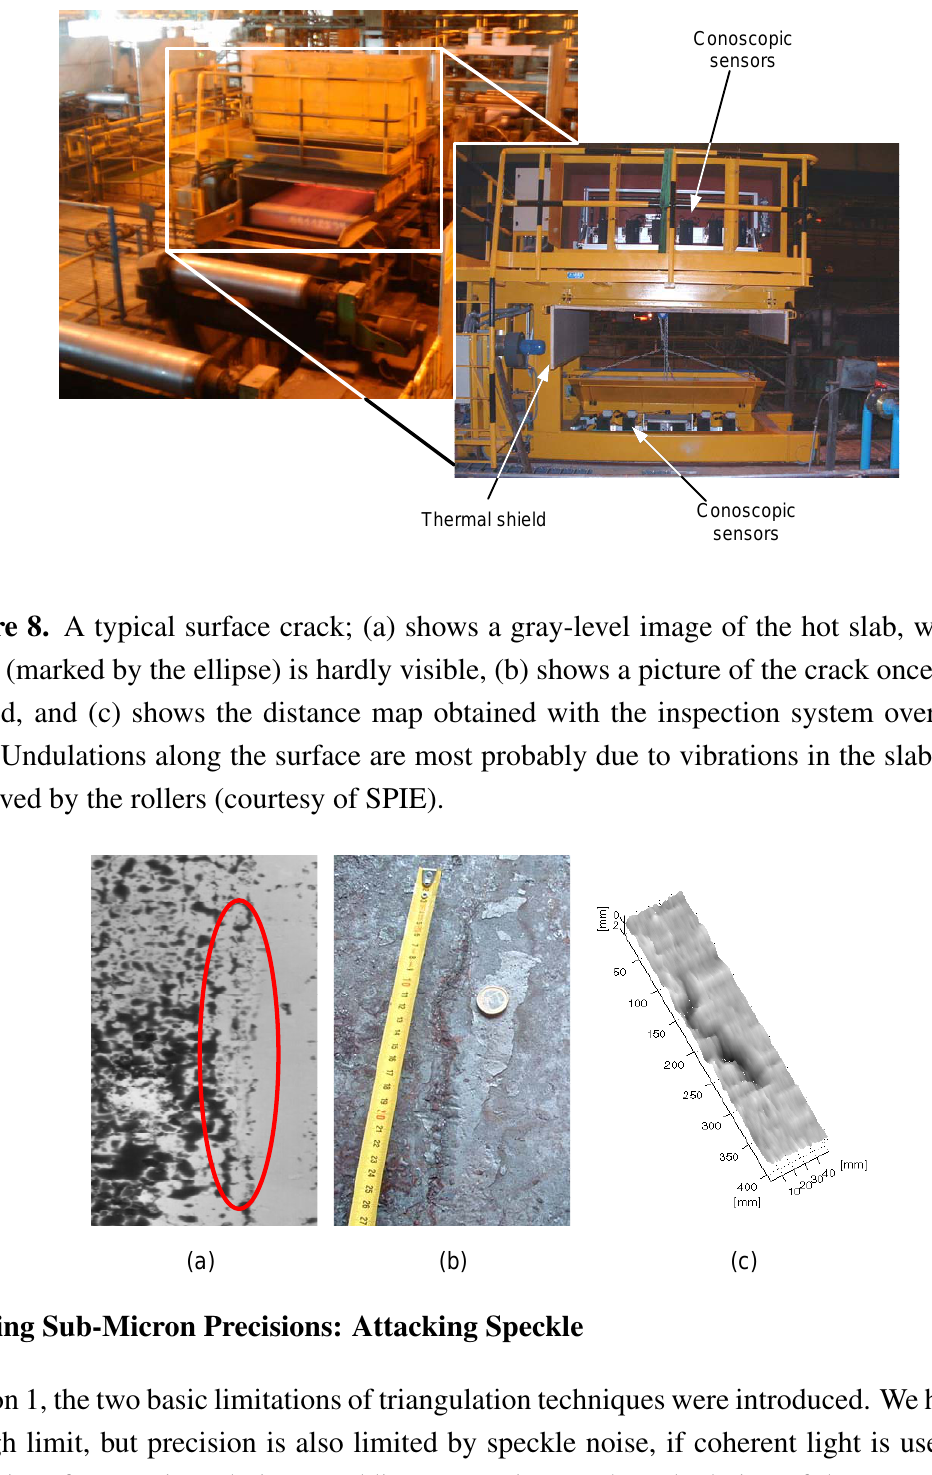
Figure 7. External view of the inspection system installed in Arcelor (Spain).